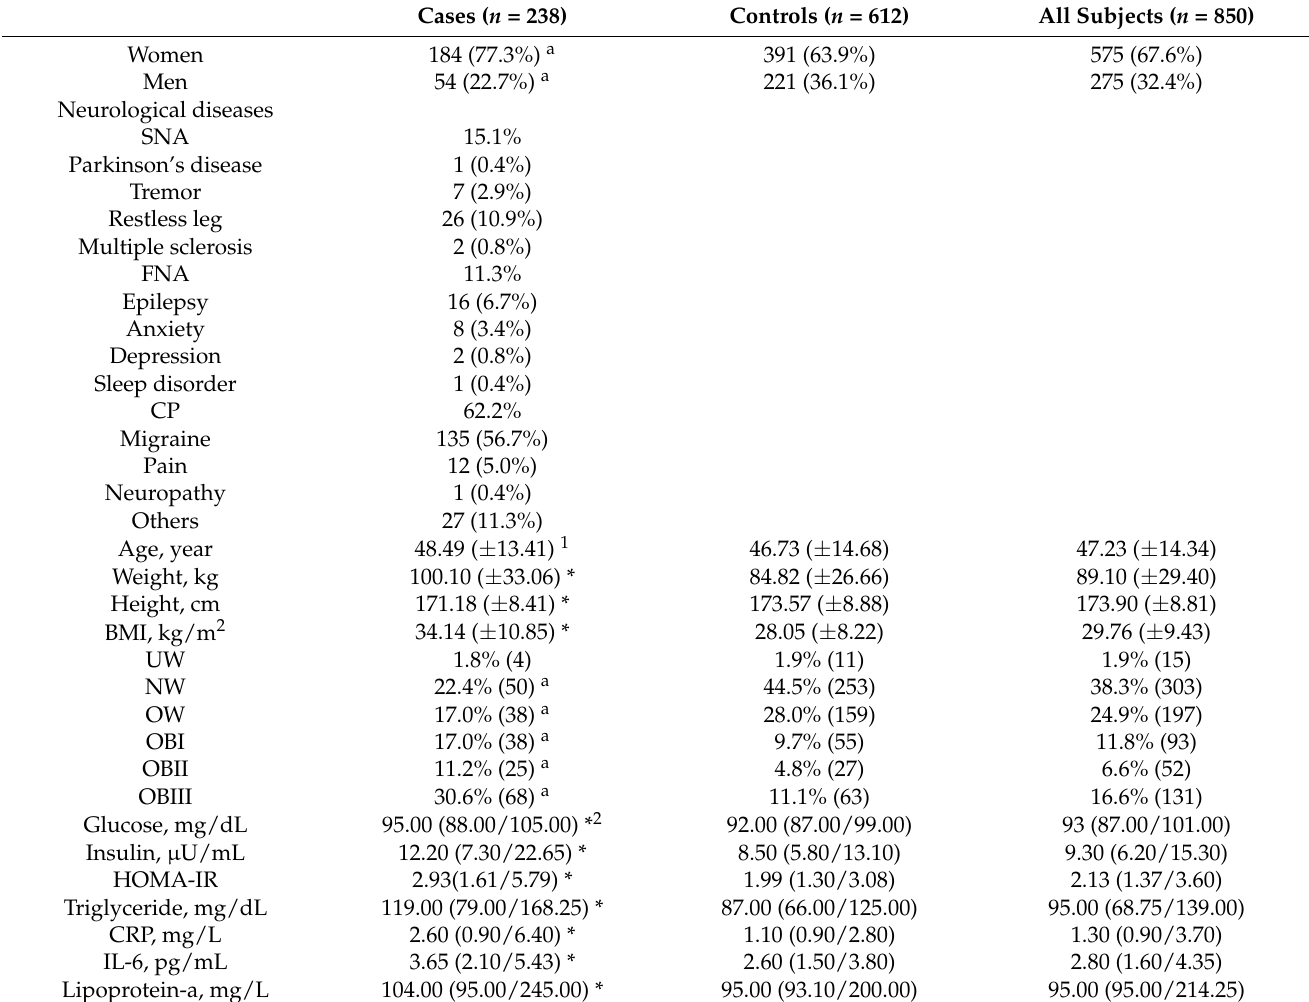
Table 1. Characterization of the FoCus subcohort according to laboratory analytical and anthropometric factors and demographic